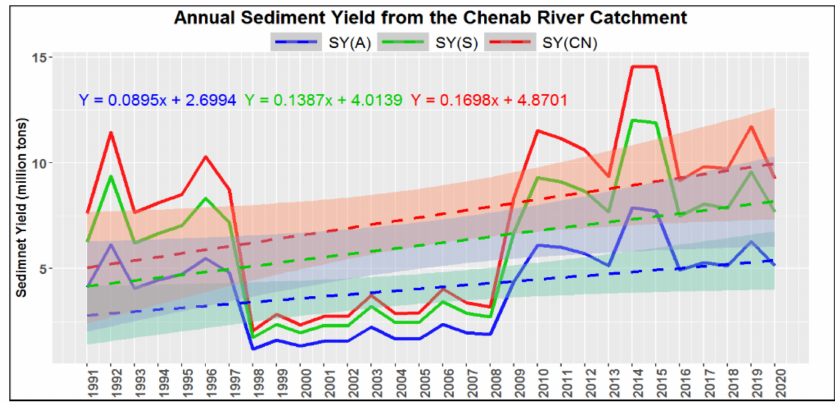
Figure 11. Annual sediment yield from the Chenab river catchment 1991 to 2020.